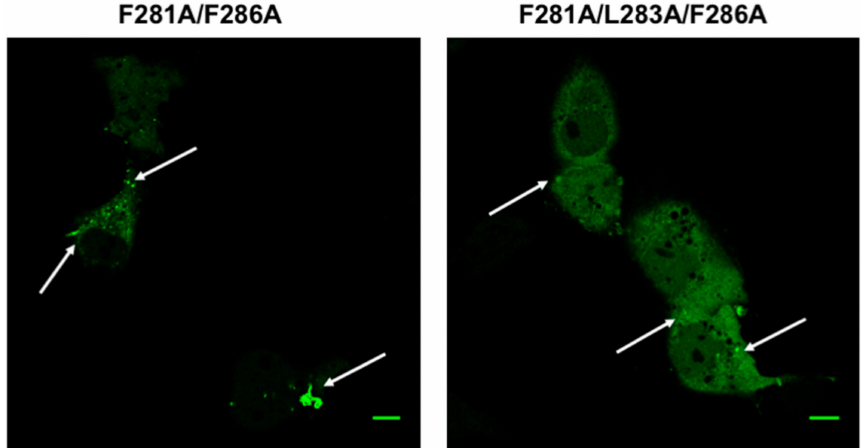
Figure6. Co-expressionofWTmVP40failedtorescuetheplasmamembranelocalizationofhydrophobic loop mutants. COS-7 cells co-transfected with WT mVP40 (hemagglutinin (HA) tagged, 0.5 µ g plasmid) and EGFP-mVP40 mutants (0.5 µ g plasmid) imaged 14 hrs post-transfection. Scale Bar = 10